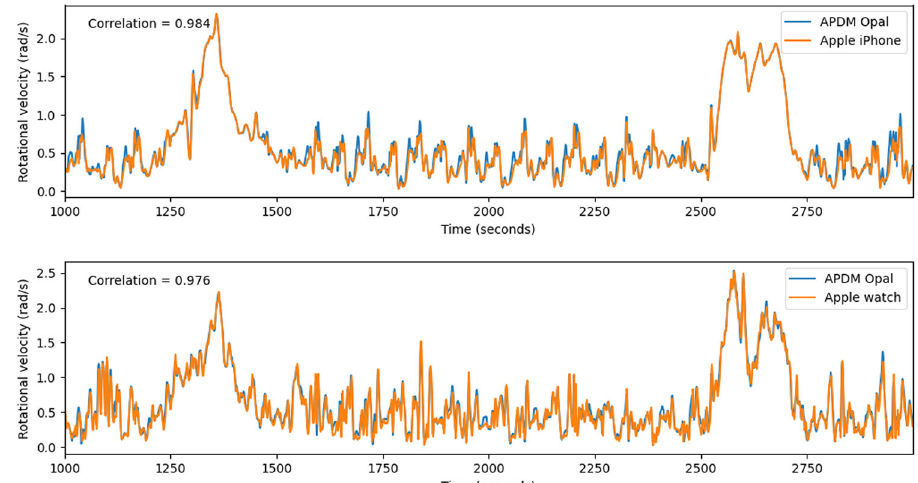
Fig. 1 Angular Velocity Comparison. Top: Comparison of angular velocity calculations using APDM Opal (blue) and iPhone (orange) samples with both devices placed at lumbar region. Bottom: Comparison of angular velocity calculated using Opal (blue) and Apple Watch (orange) samples with both devices placed on the same wrist of the